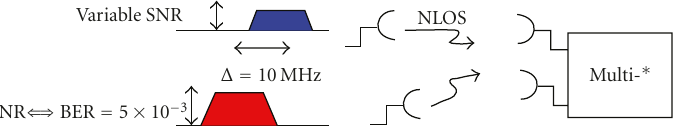
Figure 15: Definition of study case with overlapping channels and variable power of 802.11g signal.